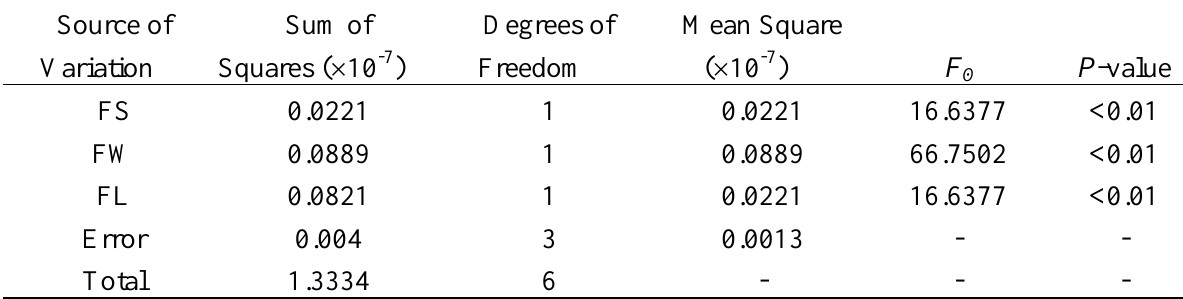
Table 5. ANOVA results for MUA-based sensing